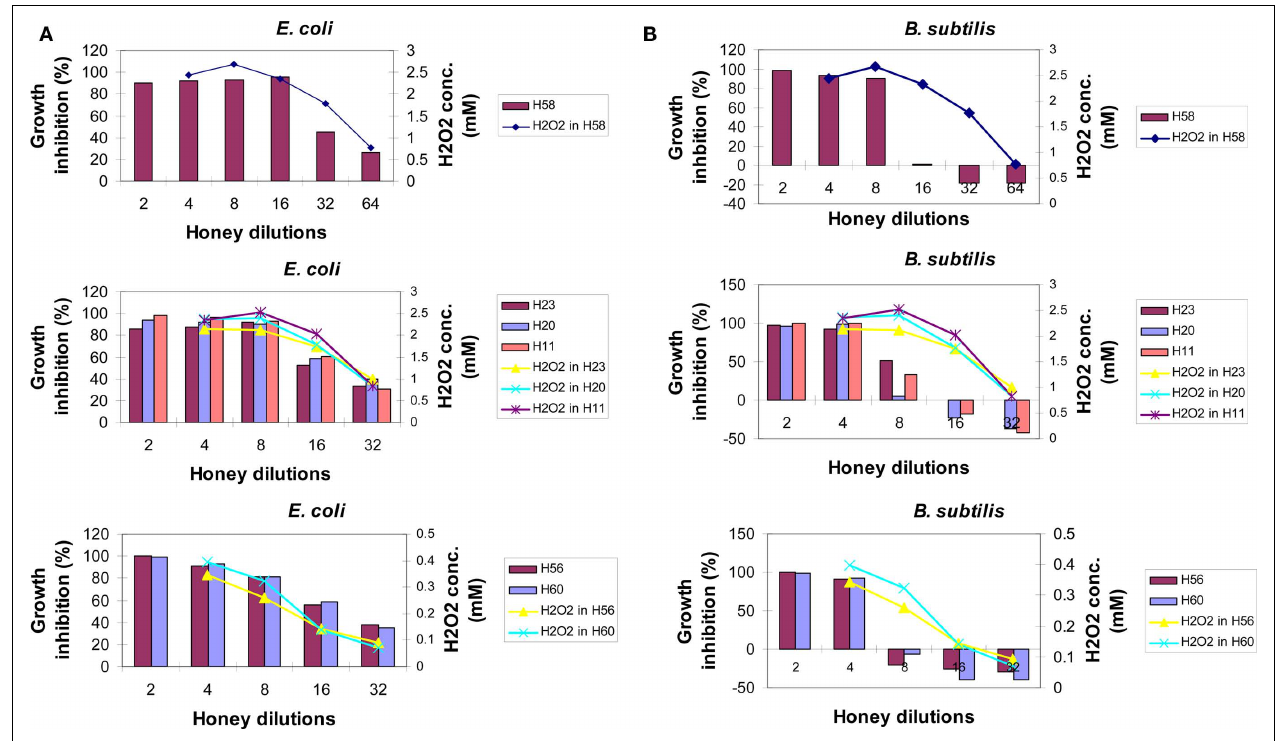
described in the Section “Materials and Methods.” Of note: growth inhibition profiles of artificial honey of osmolarity equal to that of natural honey provided MIC 90 values of 25% (v/v) against both E. coli and B. subtilis. Each point or column represents the mean values of three separate experiments run in